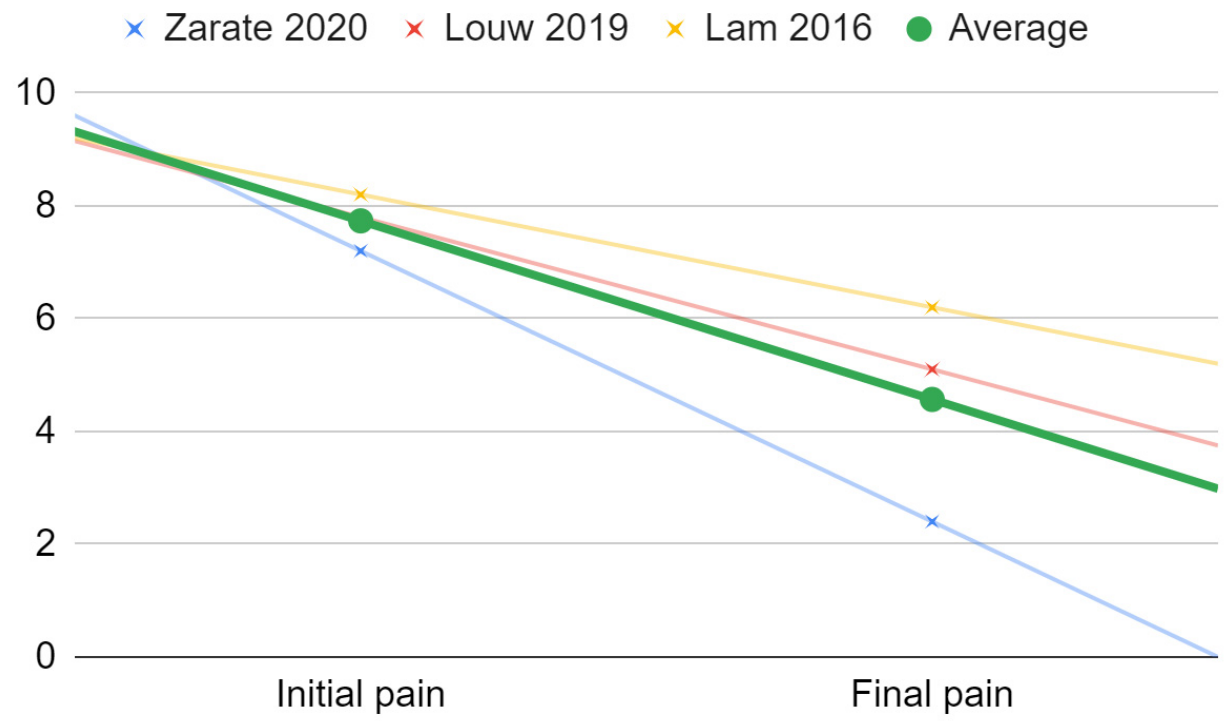
Figure 5. Final TMJ pain values after treatment with individual injectables expressed as a percentage (the pain value before treatment was 100% in each case).